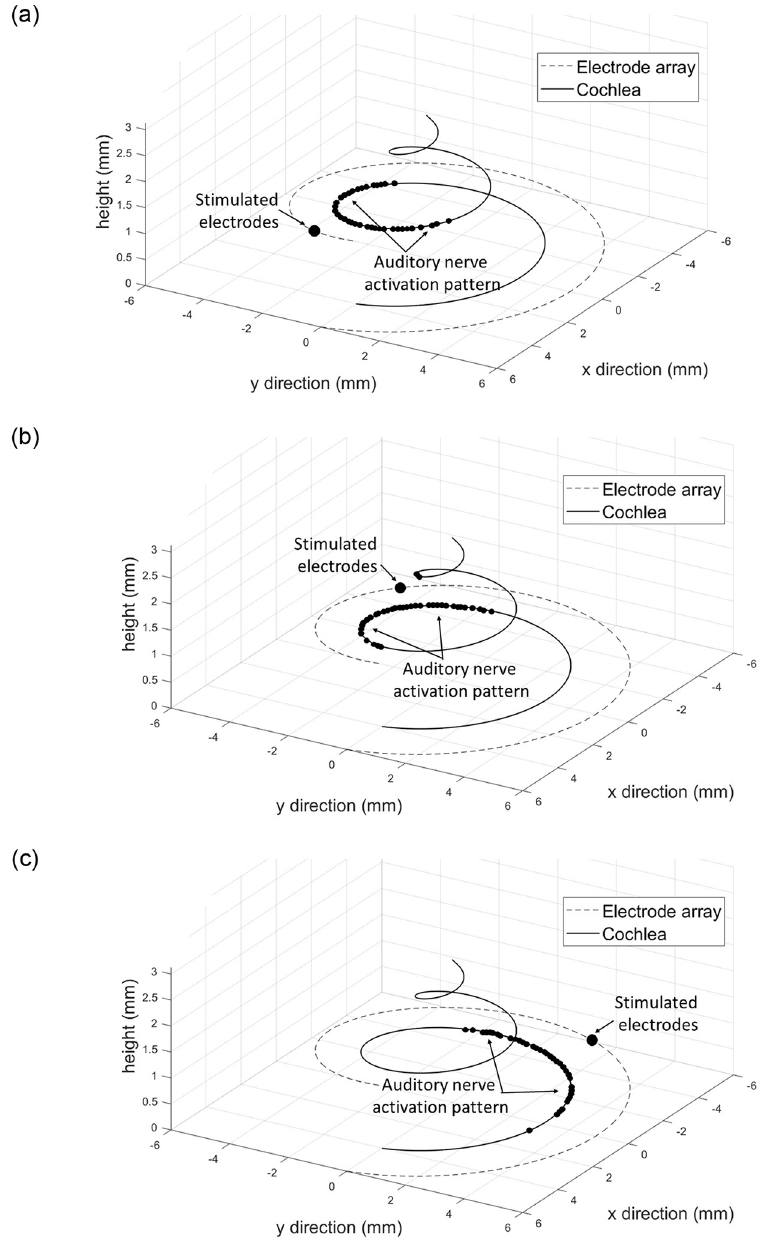
Fig 2. The activation pattern of auditory nerve fibers, Y , for a stimulated electrode. Three example cases are shown. The electrode-cochlea geometry is that shown in Fig 1, N = 1000, and A = 0.5 dB/mm. The classifier, used by [42], consists of a single hidden layer feedforward network (SLFN), where N is the number of units in the input layer (equal to the number of fibers), L is the num- ber of units in the hidden layer, and M is the number of output layer units (equal to the num- ber of electrodes). We also define two matrices that map the fiber activation samples (the input vectors) onto the indices of electrodes (the prediction vectors). The input weight matrix W (of size L × N ) maps the data from the N -dimensional input space to the L -dimensional